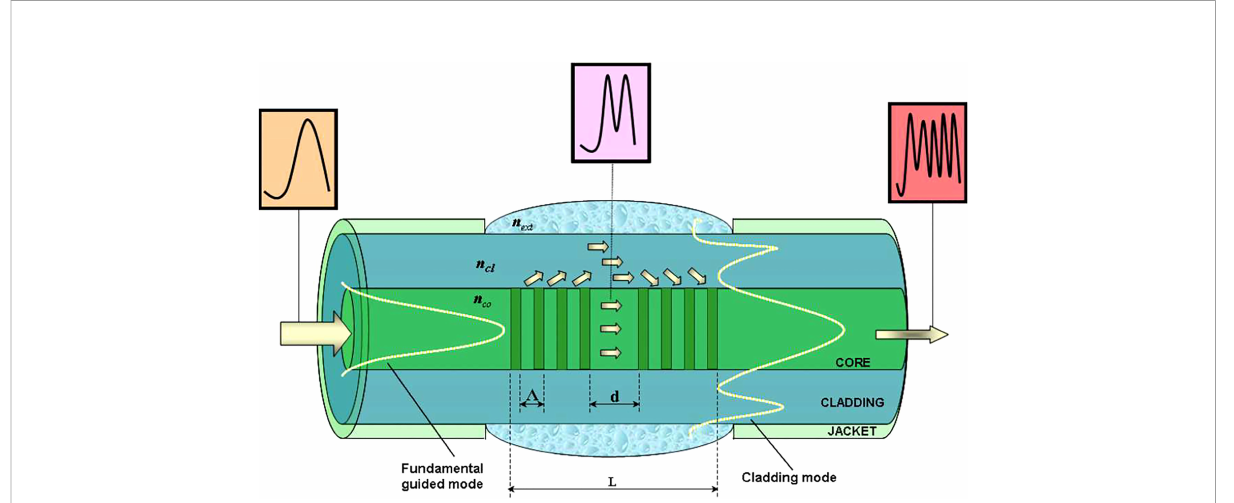
FIGURE 3 Scheme of an in- fi ber Mach-Zehnder interferometer based on two cascaded LPFGs. The spectral shape of light is represented before the fi rst grating and at the output of the second grating (from Possetti et al.,